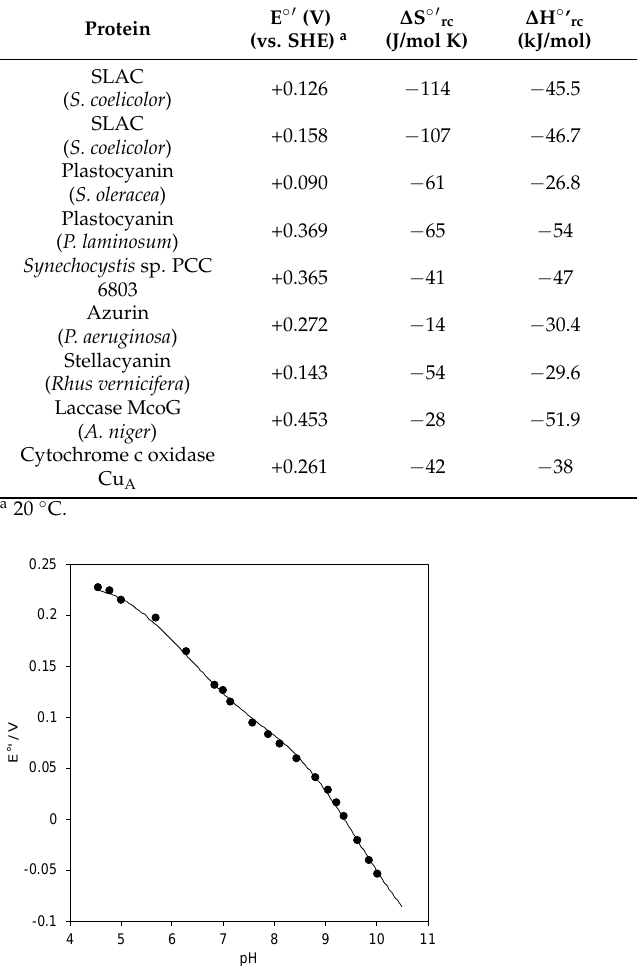
Table 2. Reduction thermodynamics for Streptomyces coelicolor small laccase (SLAC) and other immobilized blue-copper proteins at neutral pH.